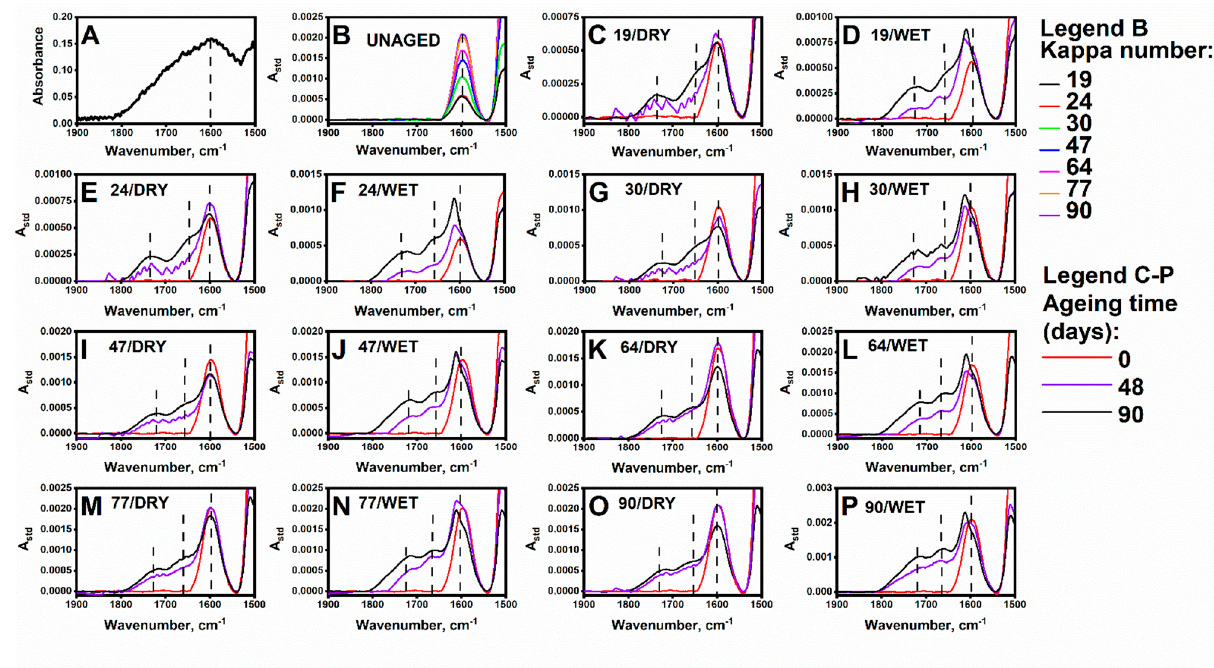
Figure 3. DRIFT spectra of ( A ) lignin, mixed with KBr; ( B ) unaged paper sheets with different Kappa numbers (spectra subjected to standardisation) ( C – P ).